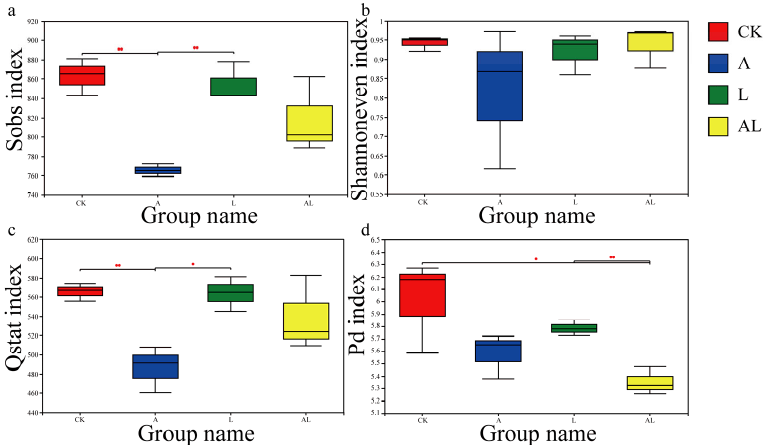
Figure 6. Biological diversity of intestinal bacteria in honeybees at the α level. The level of intestinal bacteria diversity was determined by comparing: the observed species index ( a ); the Shannon evenness index ( b ); the status and queues in the cluster index ( c ); and the phylogenetic diversity index ( d ). ‘*’ represents a statistically significant difference between two groups (independent ‐ sample t test, p < 0.05). ‘**’ represents a statistically extremely significant difference between two groups (independent-sample t test, p < 0.01).